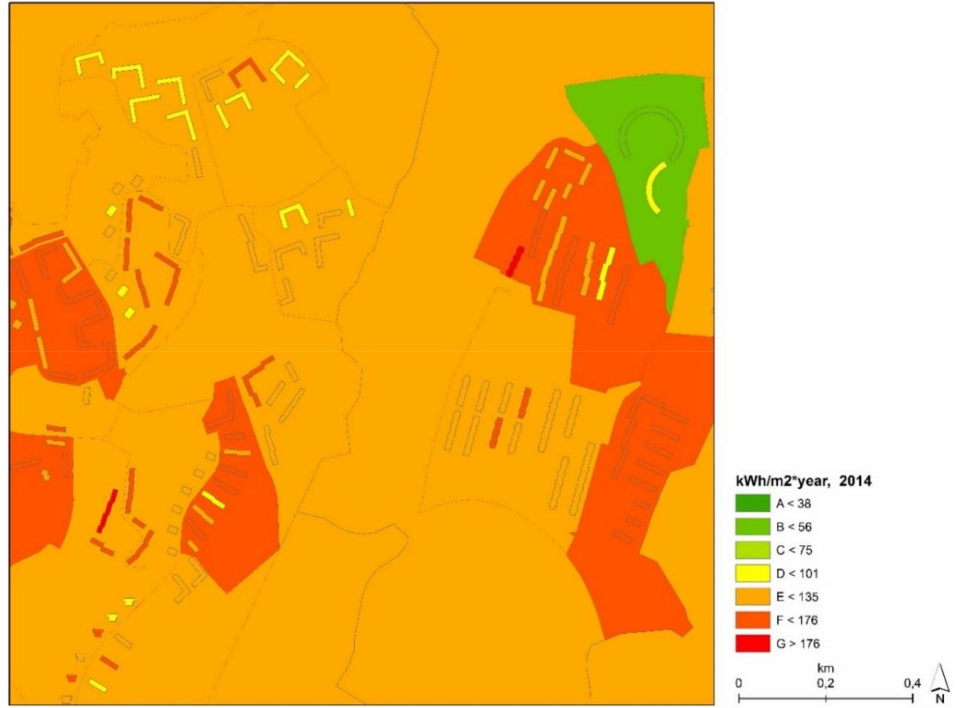
Figure 10. Energy performance for individual buildings and aggregated to statistical areas (base